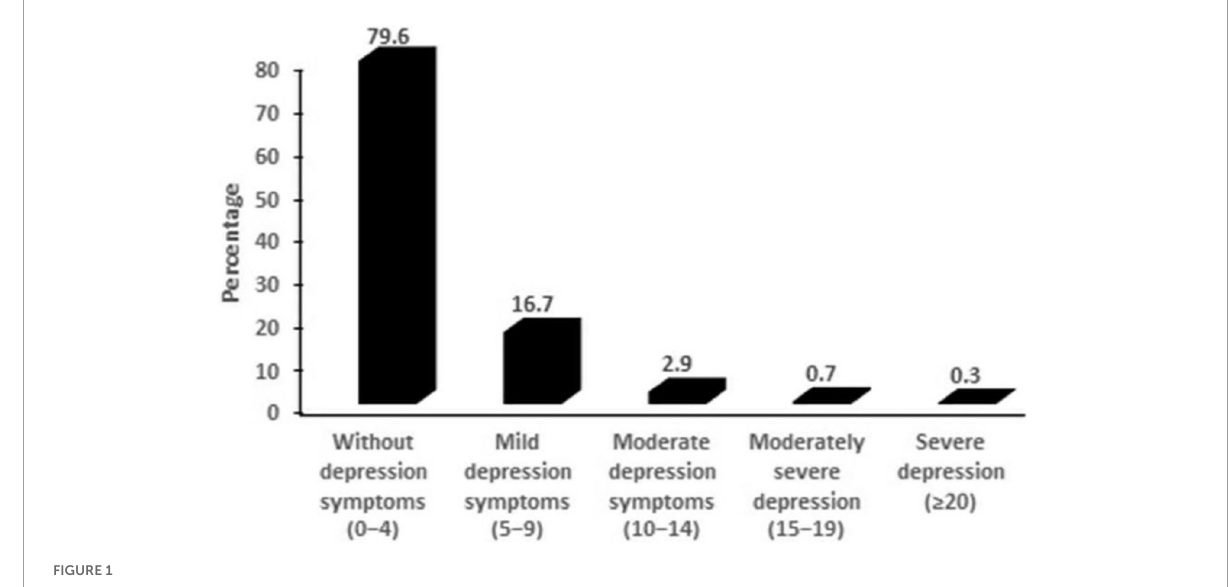
FIGURE1 Prevalence of depression symptoms among tabacco users during COVID-19 pandemic.